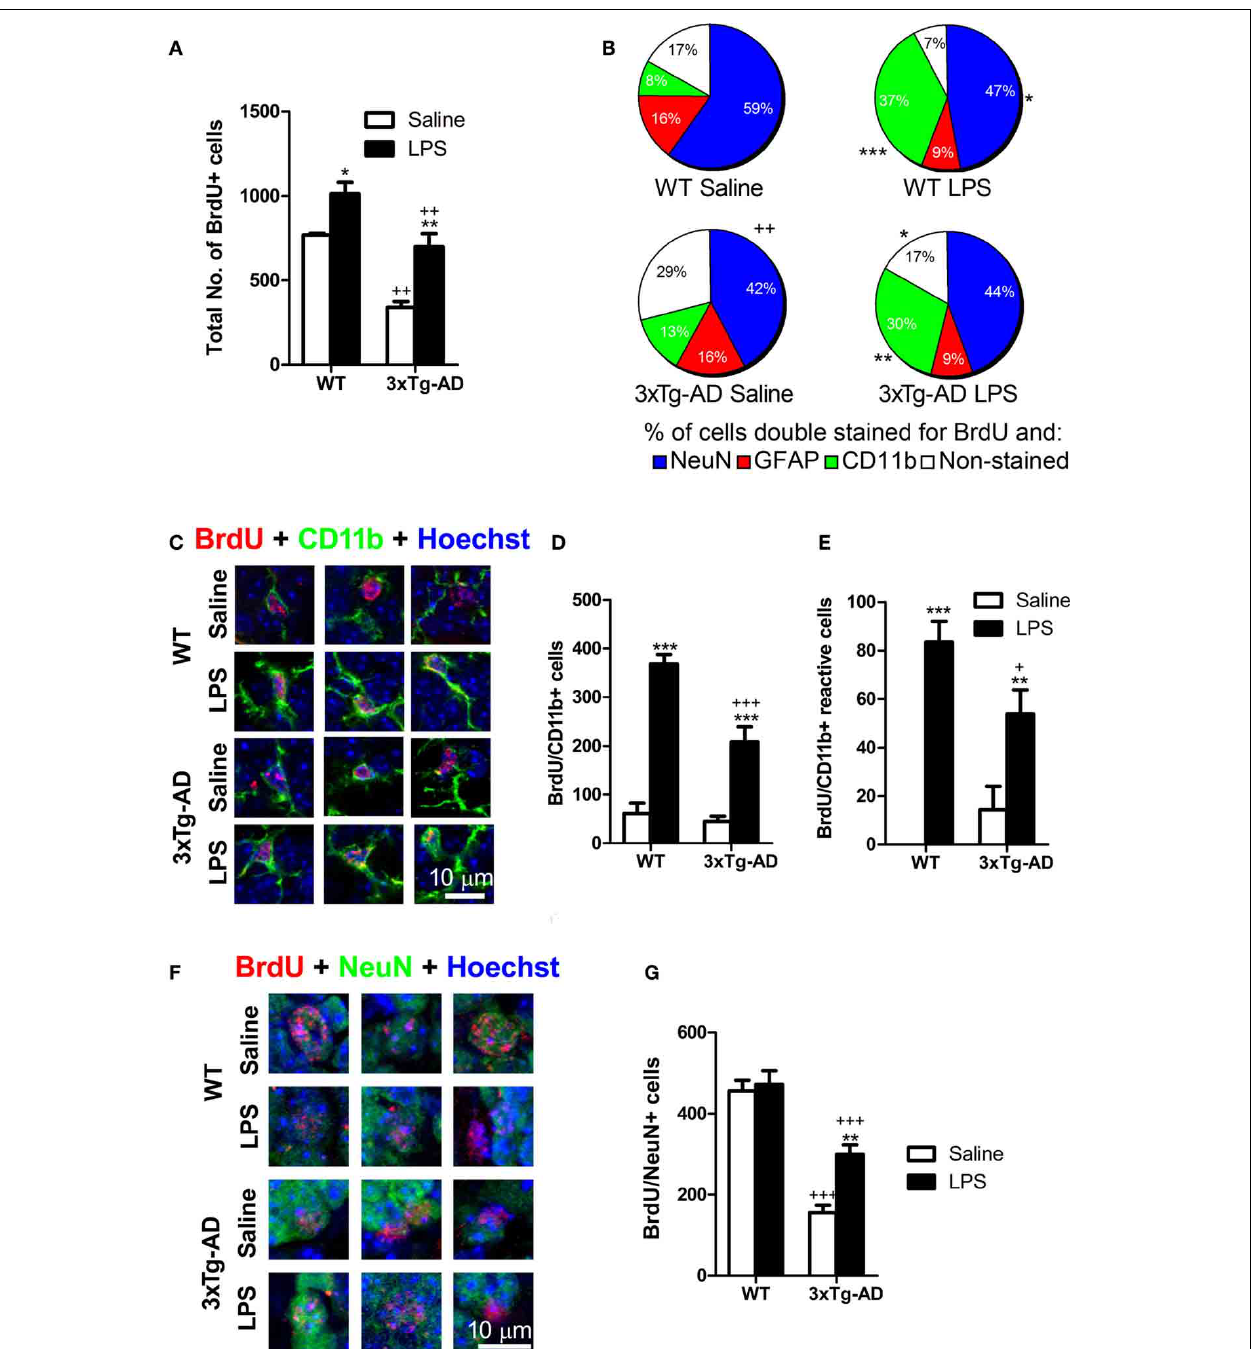
FIGURE 3 | Net outcome of early LPS effects on different types of proliferating cells. (A) Total number of BrdU cells was significantly reduced in 3xTg-AD mice but increased in the dentate gyrus of mice treated with LPS. (B) The proportion of newly-generated neurons (NeuN/BrdU cells) was diminished in 3xTg-AD mice (compared with WT mice) while the percentage of microglial/macrophage cells (CD11b/BrdU + cells) was increased after LPS treatment. (C) Confocal microscopy images showing double stained BrdU/CD11b-positive cells in the granule cell layer/subgranular zone of the dentate gyrus (hypertrophic cells showing thick processes emerging from their cell body were considered as reactive). (D) Total number of BrdU-stained microglial/macrophage